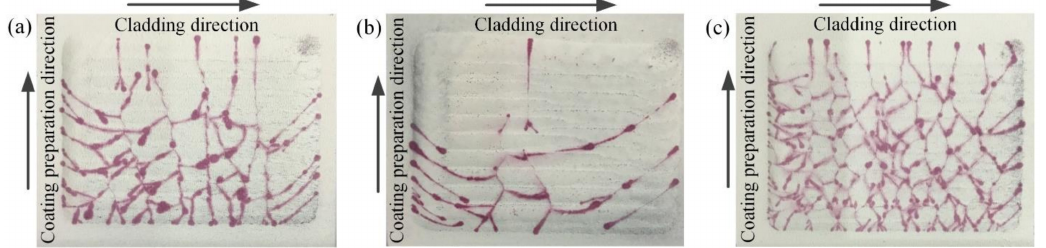
Figure 3. The penetrant test results of the coatings. ( a ) The 25 wt.% Ni-MoS 2 coating. ( b ) The 35 wt.% Ni-MoS 2 coating. ( c ) The 45 wt.% Ni-MoS 2 coating.